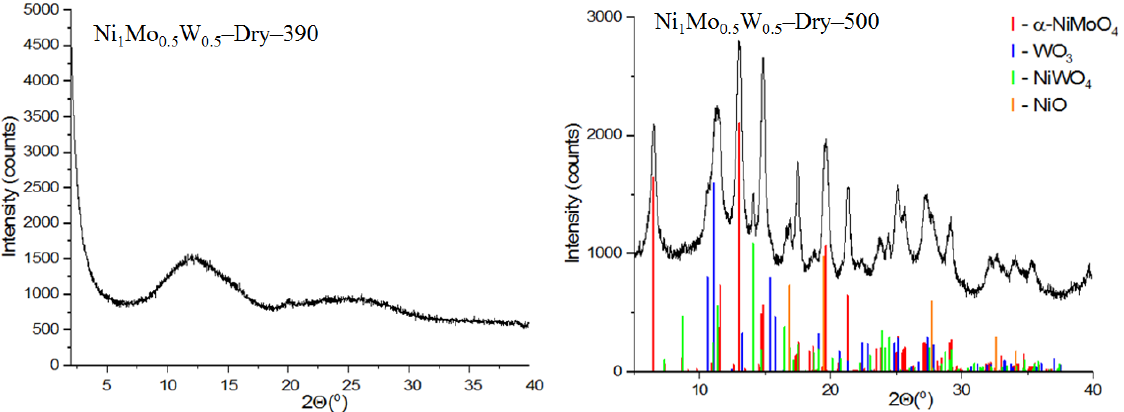
Figure 5. X-ray diffraction pattern of the Ni 1 Mo 0.5 W 0.5 – dry catalyst calcined at 390 and 500 °C.